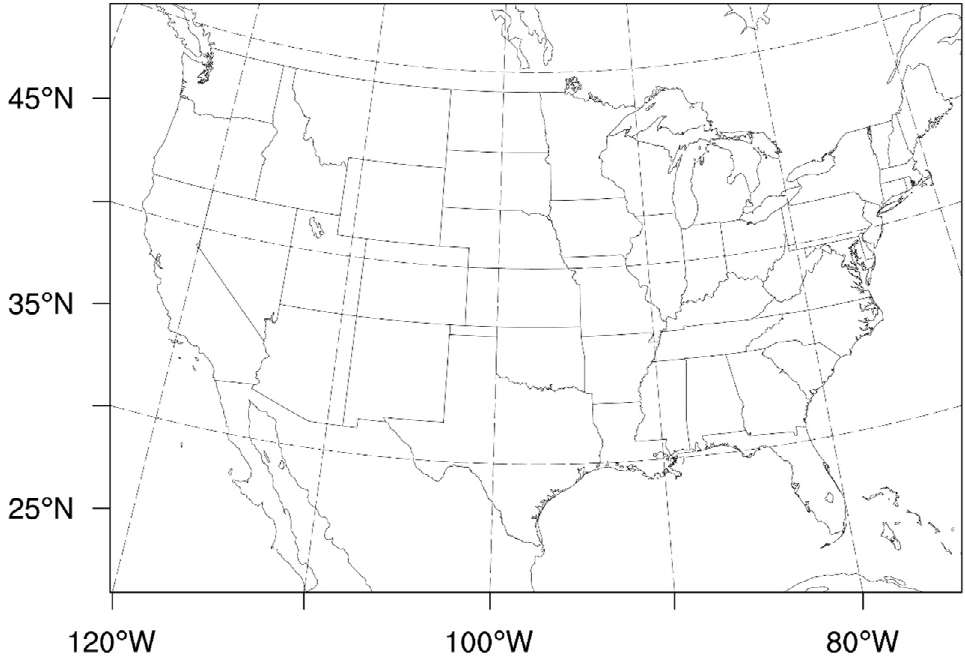
Figure 2. The model domain for the EDA system. The E-W scale of the domain is ~4860km, the N-S scale of the domain is ~3360km, and latitude/longitude dashed lines are overlaid for reference.